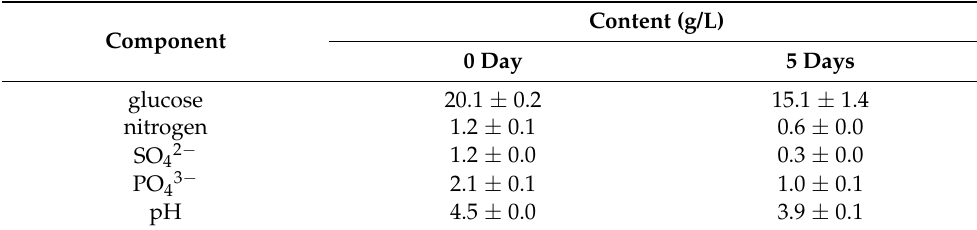
Table 2. Composition analysis of the fermentation broth of A. cinnamomea